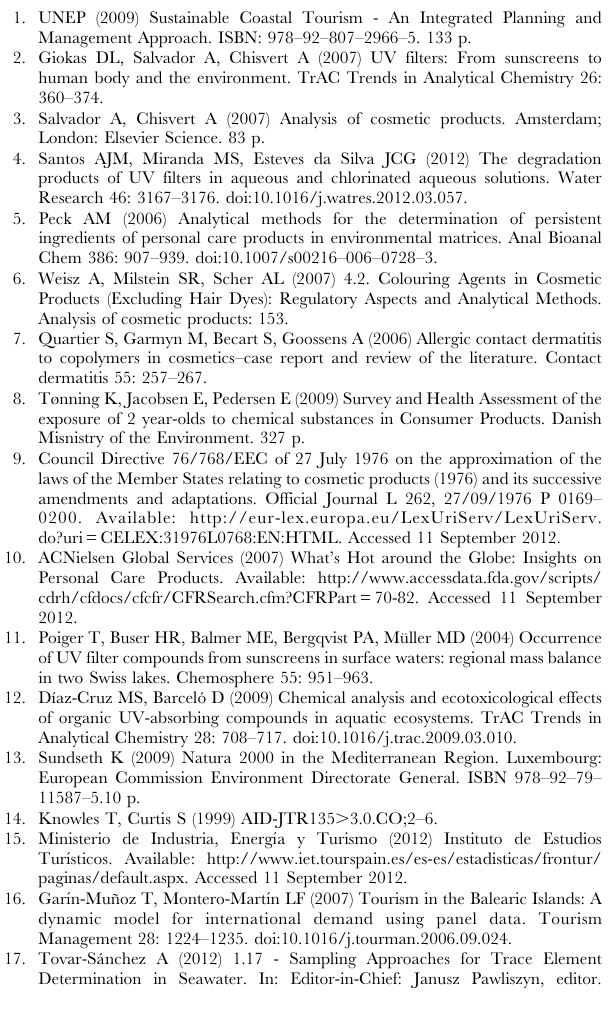
Table S1 Concentration (average ± SDV) of nutrients in nmol g -1 released from commercial sunscreens in seawater after 72 h shaking. Samples were analyzed by triplicate except for nutrients from sunscreen 4. SPF (Sun Protection Factor). Table S2 Concentration of metals in m g g -1 (average ± SDV, n = 3) in commercial sunscreens. SPF (Sun Protection Factor). Other elements such as Ag, Cd, Co, Cr, Cu, Mn, Mo, Ni, Si, Sr, Pb, Tl, V, and Zr were not